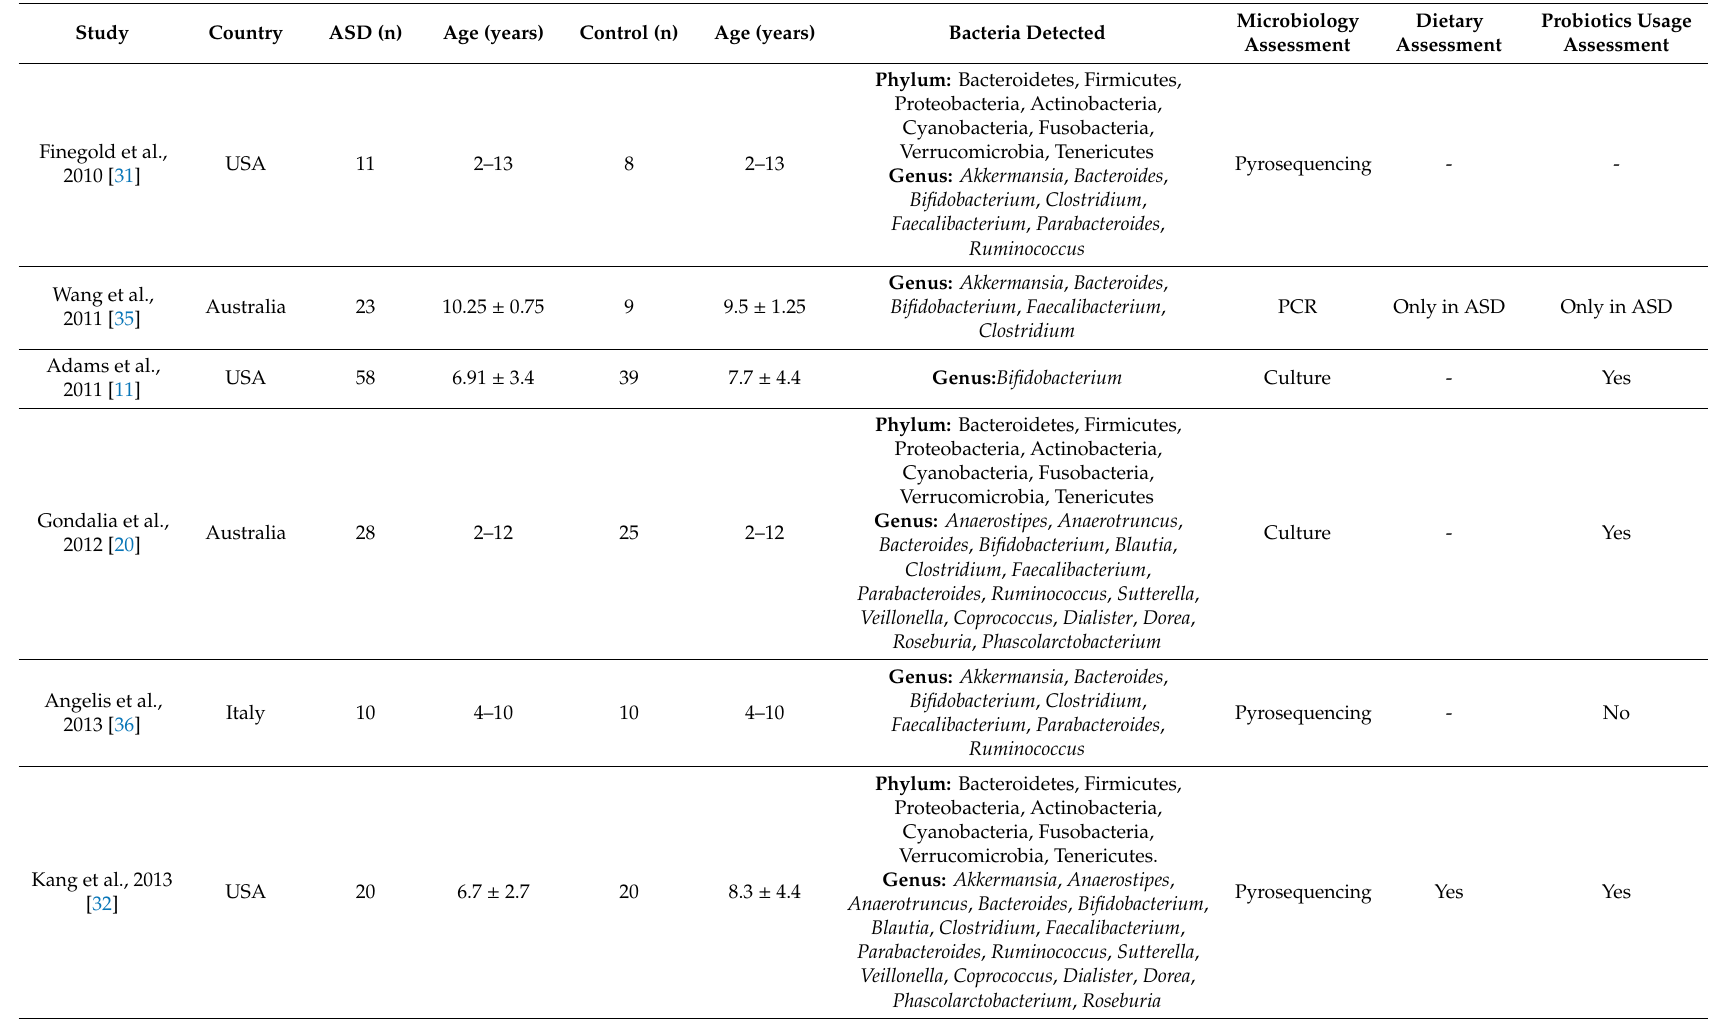
Table 1. Characteristics of the studies included in the